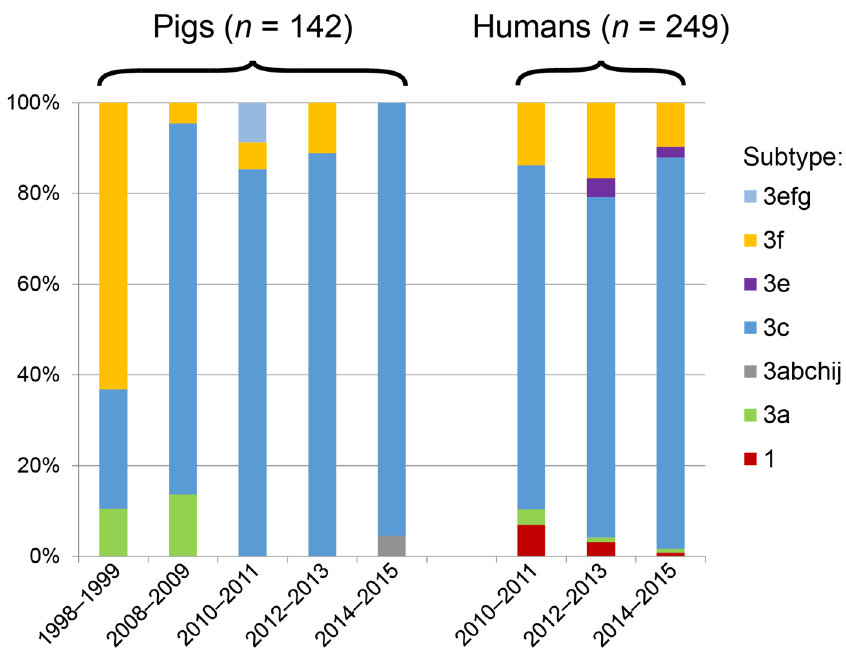
Figure 2. Summary of the difference in subgenotype distribution of HEV isolated from pigs and humans over time. The percentage of HEV sequences from each subtype from pig and human HEV was calculated from Table 1.